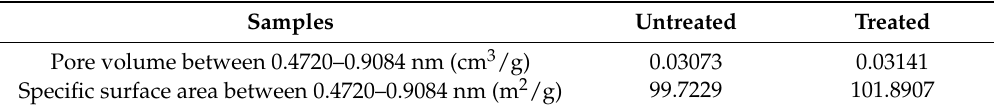
Table 6. Pore volume and specific surface area determined from carbon dioxide adsorption.